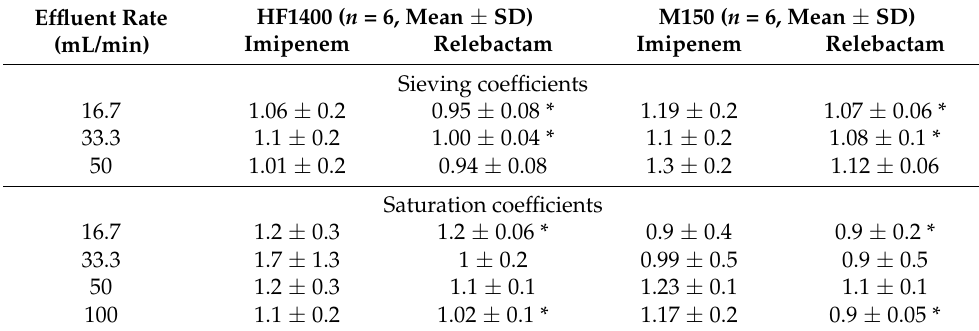
Table 1. Mean sieving coefficients and saturation coefficients of imipenem and relebactam.